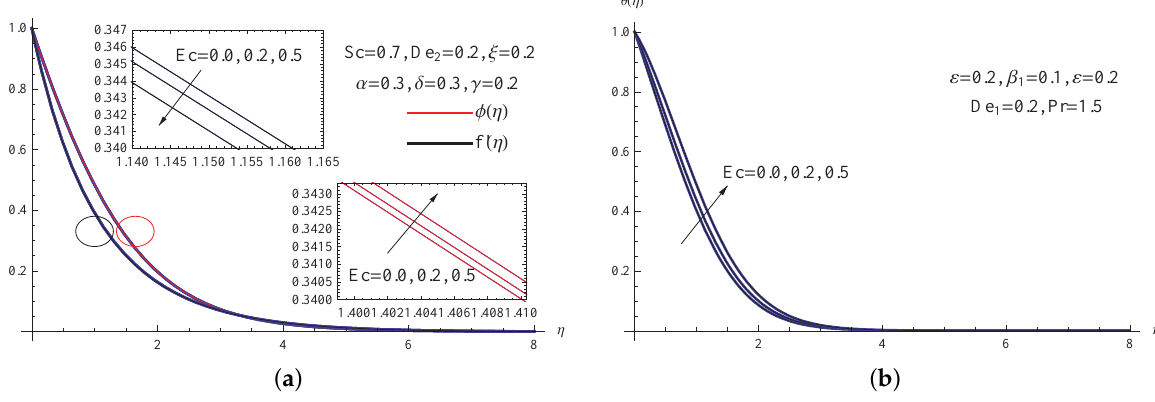
Figure 7. ( a ) f (cid:48) ( η ) and φ ( η ) for picked Ec . ( b ) θ ( η ) for picked Ec . Finally, the endeavor to evoke the impact of both the Deborah number, which con- nected with the mass transfer De 2 , and the chemical reaction parameter ξ on the mass transfer mechanism φ ( η ) has been made by drawing Figure 8. It is obvious that the incre- ment in both parameters De 2 and ξ may help in creating an obstruction for the behavior of the fluid concentration mechanism φ ( η ) . Physically, a higher De 2 indicates a longer period for the mass flux to relax. As a result, with greater De 2 , the minimum mass diffusion rate occurs, lowering the fluid concentration.